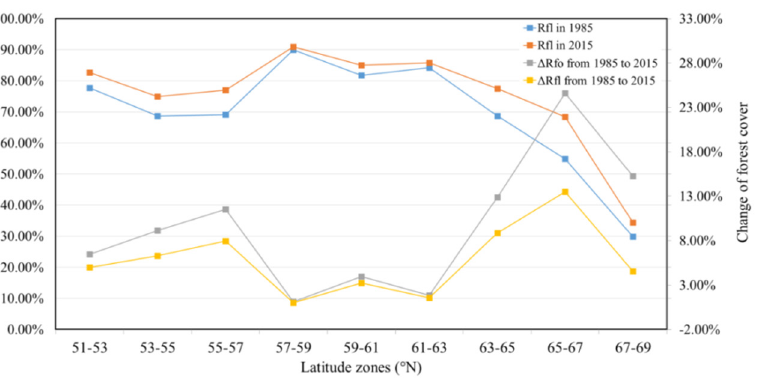
Figure 6. Line chart of the rates and the changes of forest cover in different latitude zones.